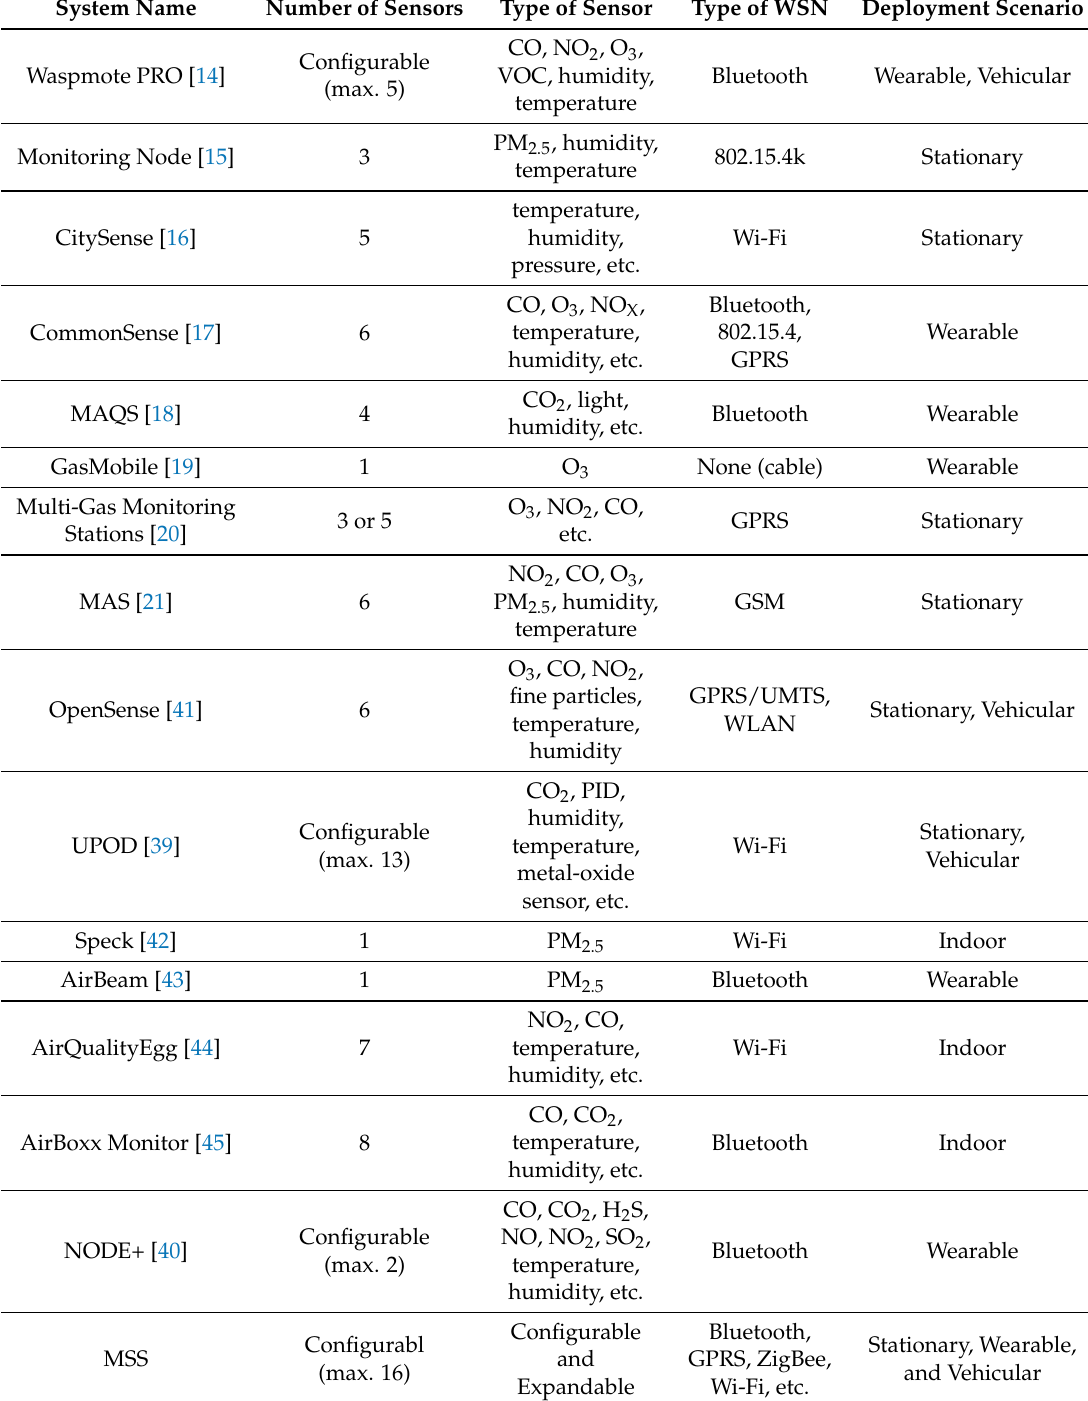
Table 2. Comparison between the MSS and similar systems. (VOC: Volatile Organic Compound; PM: Particulate Matter; MAQS: Mobile Air Quality Sensing; GPRS: General Packet Radio Service; MAS: Mini Air Station; GSM: Global System for Mobile Communications; UMTS: Universal